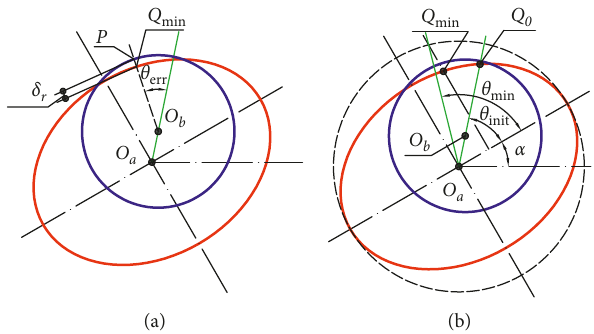
Figure 6: Schematic of 3D joint geometry in Q